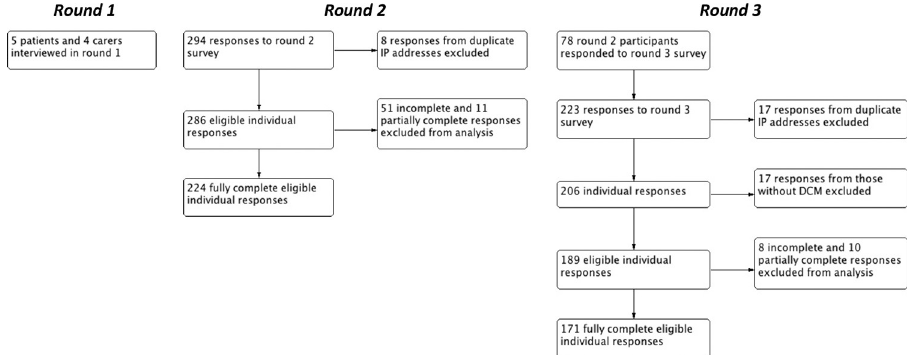
Fig 1. Flowchart of the study design. The findings from previous semi-structured (Round 1) interviews [20] and paired internet survey (Round 2) [16], were used to produce this survey (Round 3).